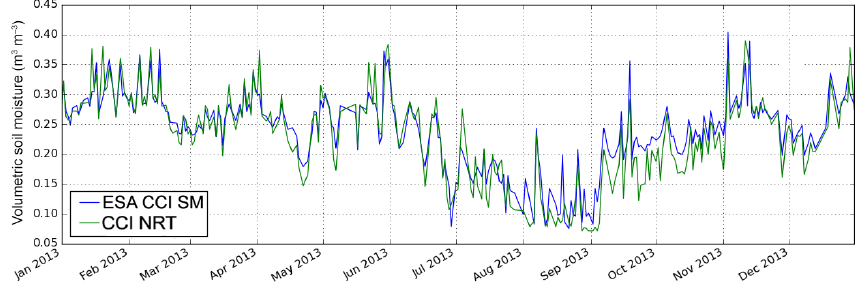
Figure 6. Illustration of ESA CCI SM and CCI NRT over the Urgons station of the SMOSMANIA network ( R = 0.93; S = 0.96).